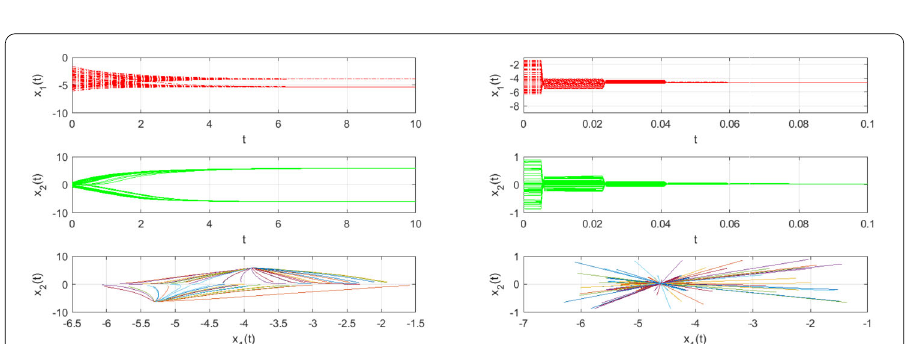
Figure 2 Transient behavior and state trajectories of x 1 and x 2 nearby the equilibrium point x (4) = (–4.6061,0.0284) T without impulsive input in the left graphs, and with impulsive input in the right